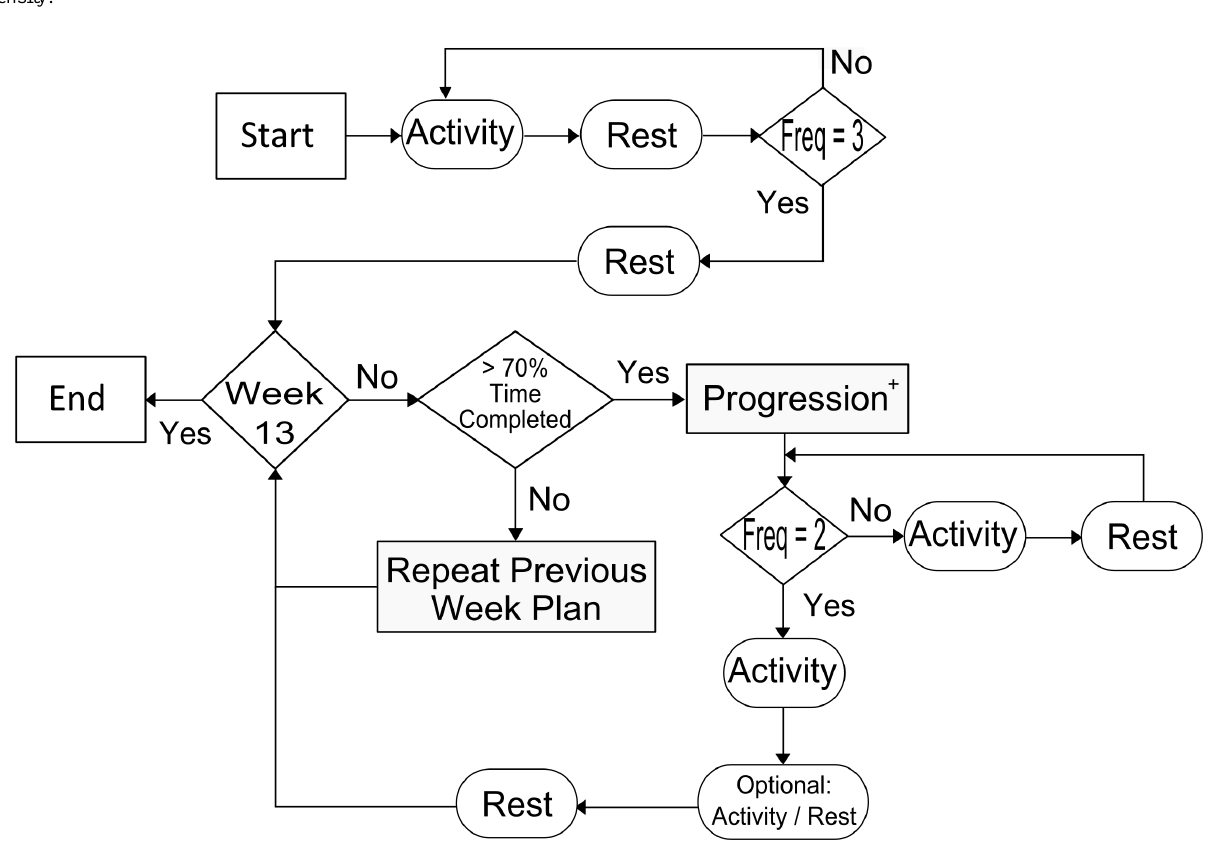
Figure 1. Illustration of the PPAP Algorithm used to decide the sequence of activity and rest sessions and the progression of exercise duration or